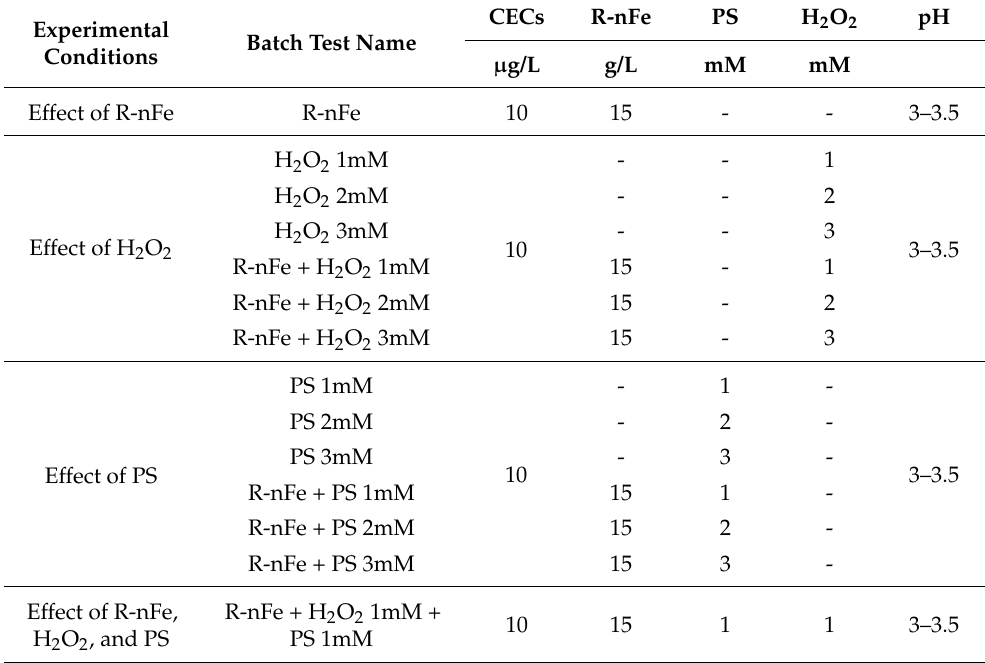
Table 2. Experimental conditions studied in the batch